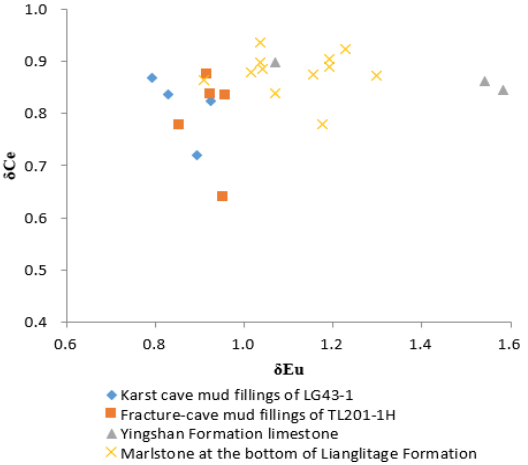
Figure 9. Characteristic of δ Ce and δ Eu of fracture ‐ cave fillings in the northern slope of